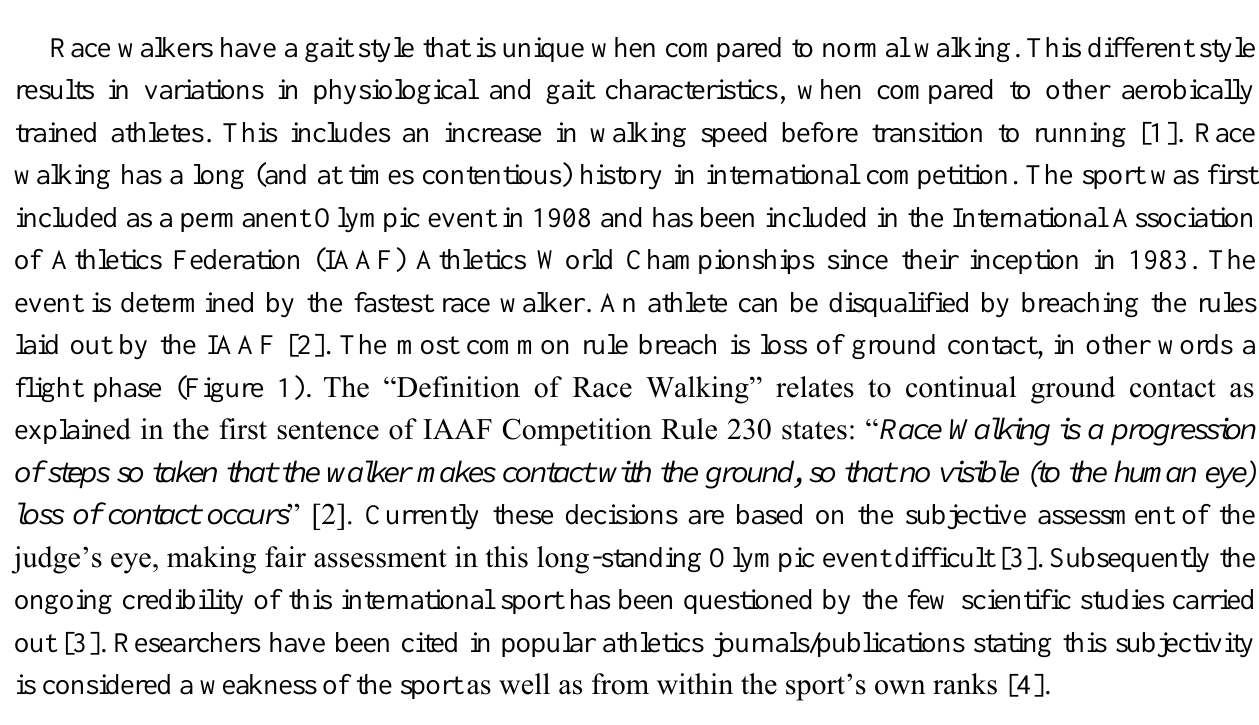
Figure 1. An athlete shown with no ground contact, therefore an illegal walking